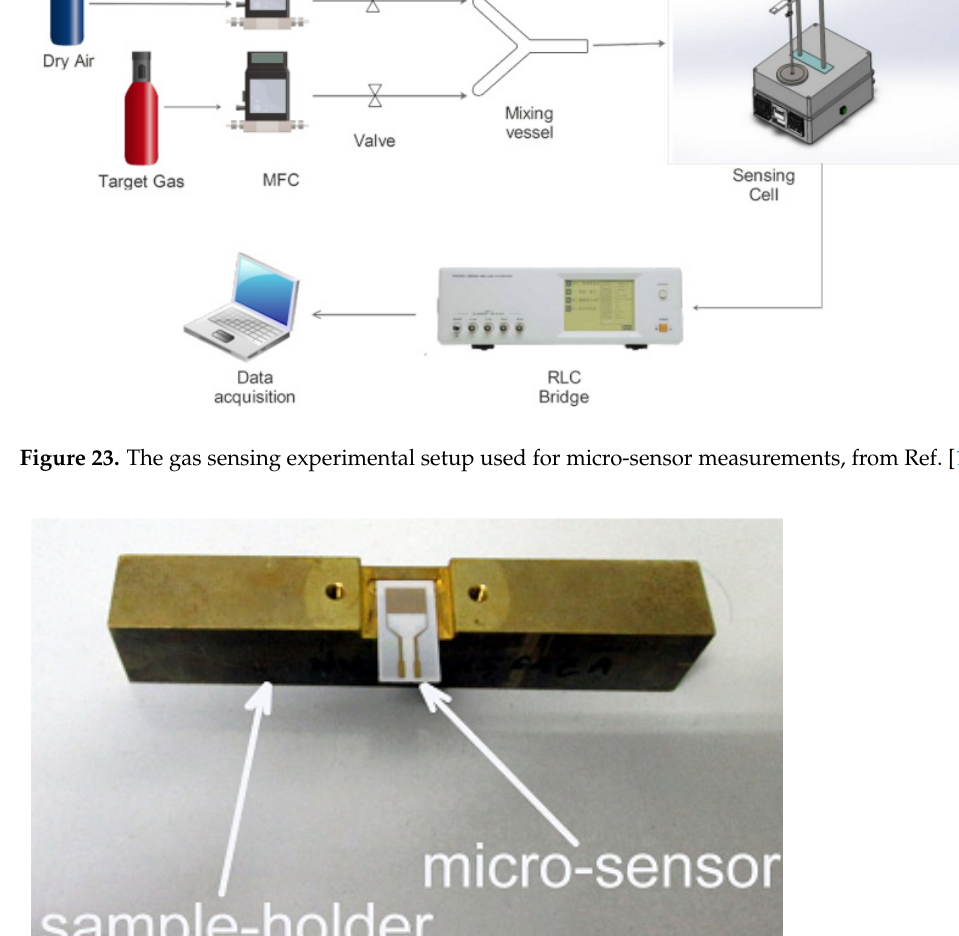
Figure 24. The sample holder with a micro-sensor in place, from ref. [126].